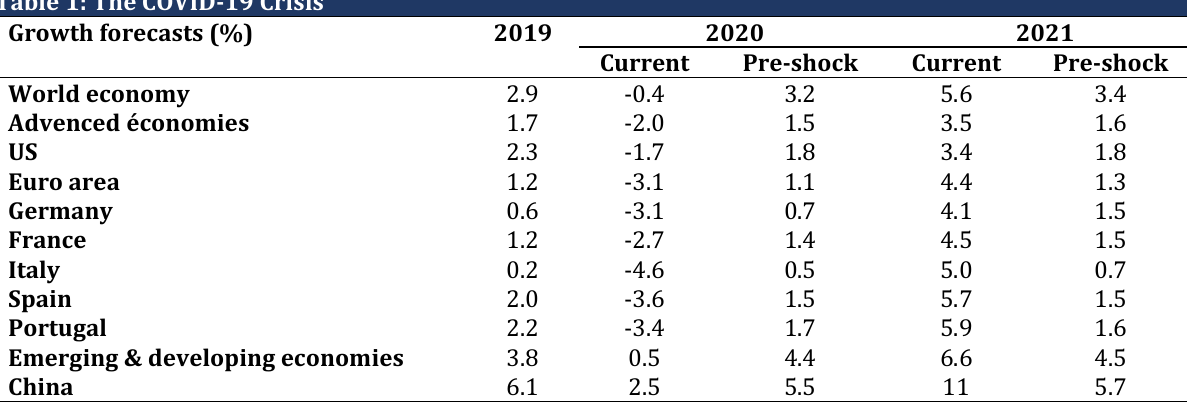
Table 1: The COVID-19 Crisis Growth forecasts